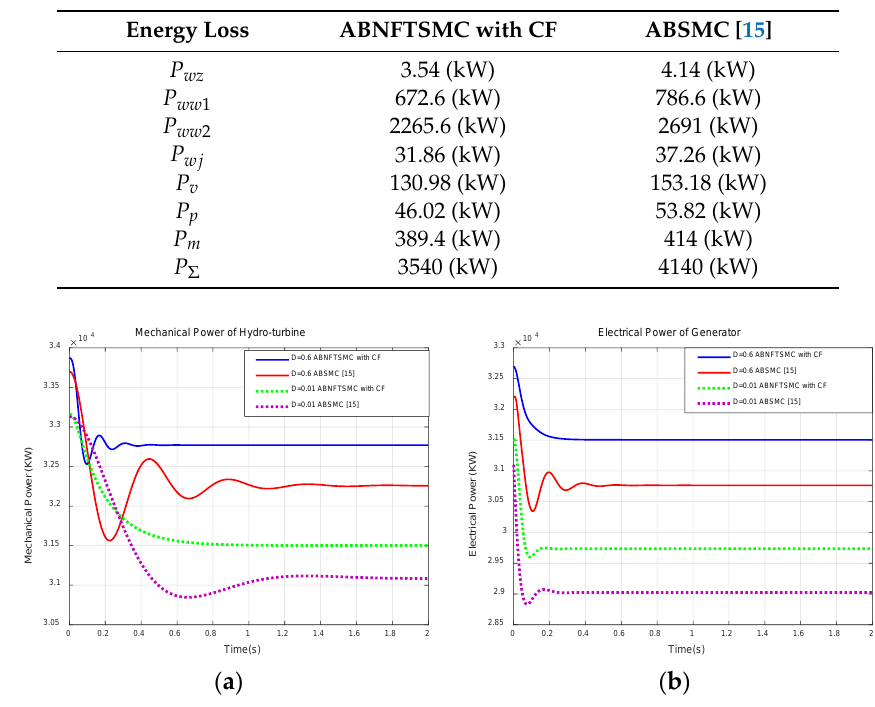
Table 2. The comparison of power losses under stochastic intensity D = 0.6.